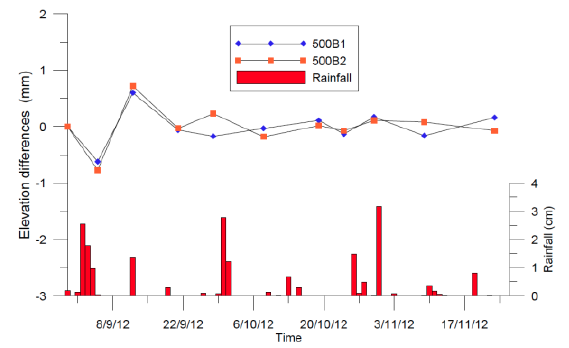
Figure 10. Elevation differences between two contiguous measurement epochs (h ti -h ti-1 ) for benchmarks fixed in soil at 5m